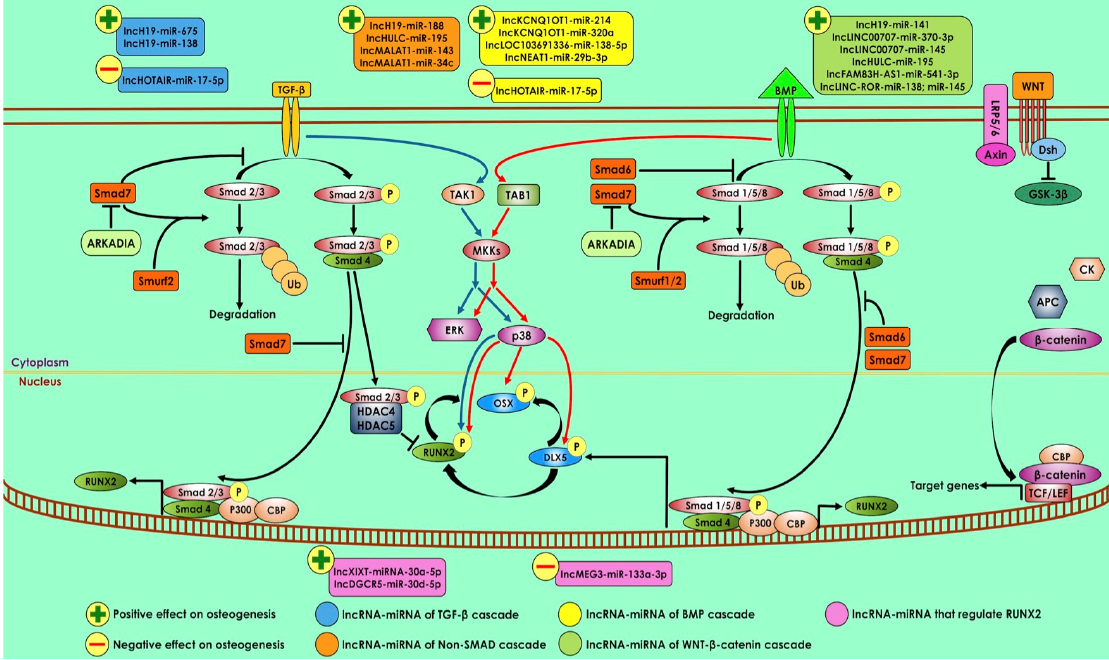
Figure 1. The contribution of various long non-coding RNAs and microRNAs in osteogenic pathways. Numerous lncRNAs and miRNAs have been shown to engage in different osteogenic pathways including BMP, transforming growth factor- β (TGF- β ), and Wnt/ β -catenin cascades, leading osteogenic differentiation in BMSCs. The binding between BMP and TGF- β with receptors activates SMAD-dependent and SMAD-independent cascades. SMAD2/3 (R-SMAD) is phosphorylated through the TGF- β SMAD-dependent signaling pathway. R-SMAD (phosphorylated) potentially interacts with SMAD4 and enters the nucleus. Further, R-SMAD and SMAD4 with CBP and P300 co-activators influence RUNX2 expression. Within the nucleus, R-SMAD interacts with HDAC4/5 and inhibits RUNX2 expression. Interestingly, non-phosphorylated R-SMAD is broken down by ubiquitination. Several ncRNAs including lncH19-miR-675 and lncH19-miR-675 positively regulate TGF- β SMAD-dependent pathways while lncHOTAIR-miR-17-5p regulates negatively. Significantly, Smurf1/2 and SMAD6/7 express inhibitory action in the BMP SMAD-dependent cascade (R-SMAD and SMAD1/5/8). Specifically, ncRNAs including lncKCNQ1OT1-miR-320a, lncKCNQ1OT1-miR- 214, lncNEAT1-miR-29b-3p, and lncLOC103691336-miR138-5p are associated with BMSC growth and differentiation. Moreover, the SMAD-independent signaling event encourages the phosphorylation of RUNX2, DLX5, and OSX. The phosphorylation of RUNX2, DLX5, and OSX is significantly favored by lncHULC-miR-195, lncH19-miR-188, lncMALAT1-miR-143, and lncMALAT1-miR-34c axes. The Wnt/ β -catenin pathway induces osteogenic differentiation in BMSCs through β -catenin transporta- tion into the nucleus and following target gene expression. The Wnt/ β -catenin pathway is positively regulated by lncLINC00707-miR-370-3p, lncH19-miR-141, lncHULC-miR-195, lncLINC00707-miR-145, lncLINC-ROR- miR-138, lncFAM83H-AS1-miR-541-3p, and miR-145. In RUNX2, lncXIXT-miRNA- 30a-5p, and lncDGCR5-miR-30d-5p are the positive regulators while lncMEG3-miR-133a-3p inhibits RUNX2